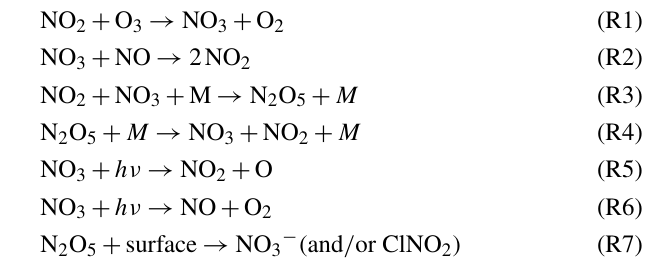
Figure 1. Gas-phase formation and loss of tropospheric NO 3 in- dicating processes which transfer reactive nitrogen to the particu- late phase. RONO 2 are alkyl nitrates. VOC is volatile organic com-